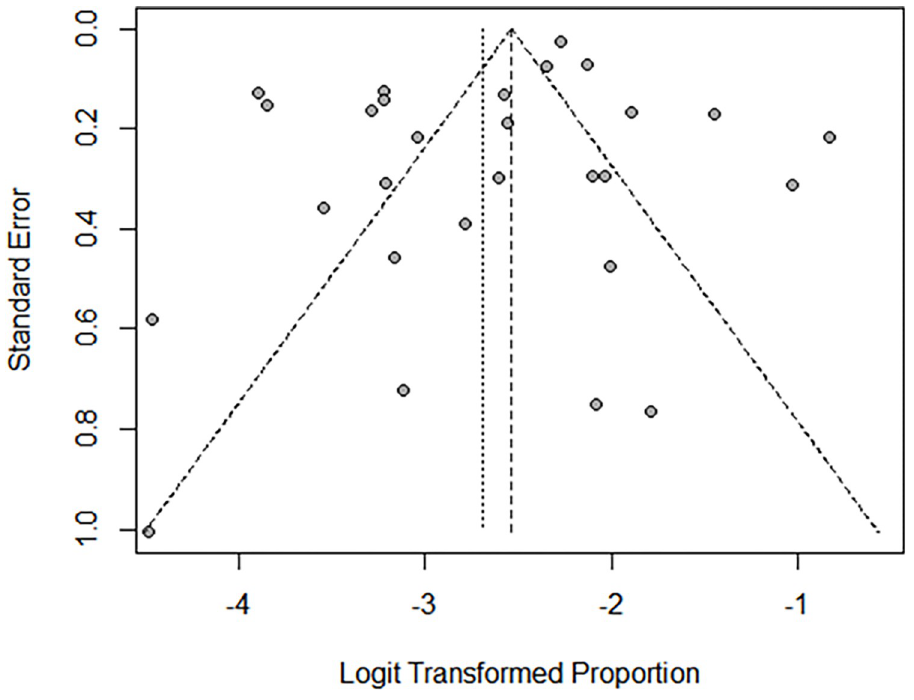
Fig 2. Funnel plot for publication